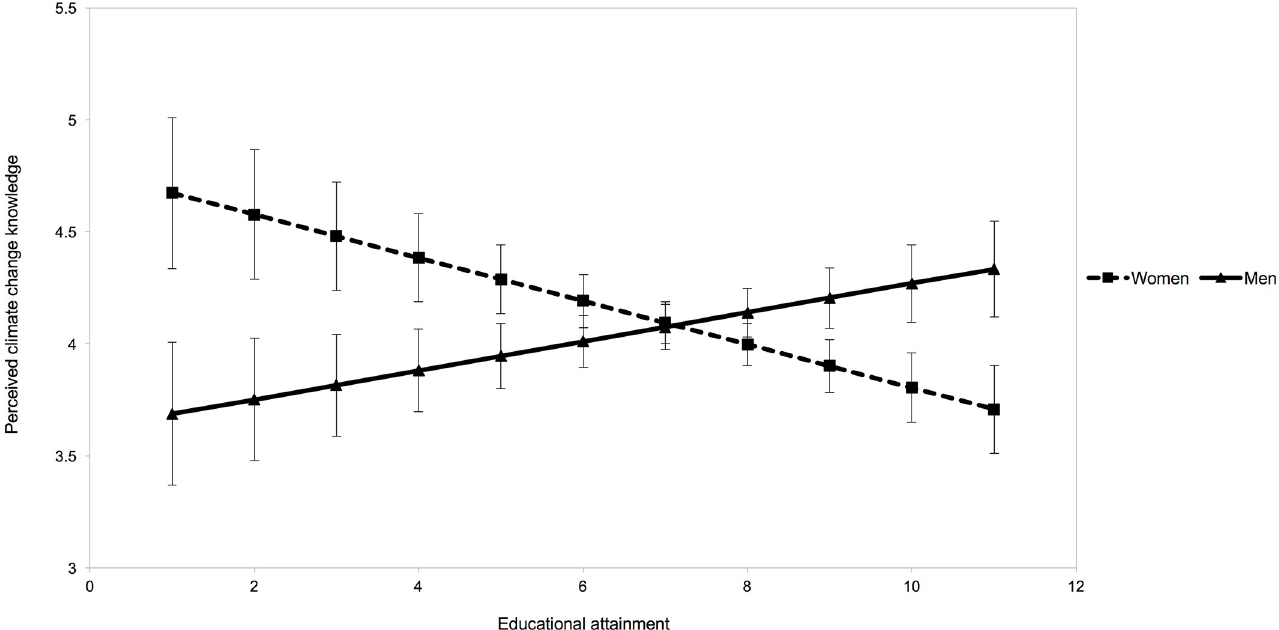
Fig 1. Effect of education on self-perceived climate change knowledge among women and men. Both regression lines predicting climate change knowledge were generated from the regression equation used to generate results in Table 1—where demographic variables, as well as drought and disaster experience predict climate change knowledge. Error bars represent standard error. Y-axis starts at 3 as no respondents self-reported knowledge levels below 3.